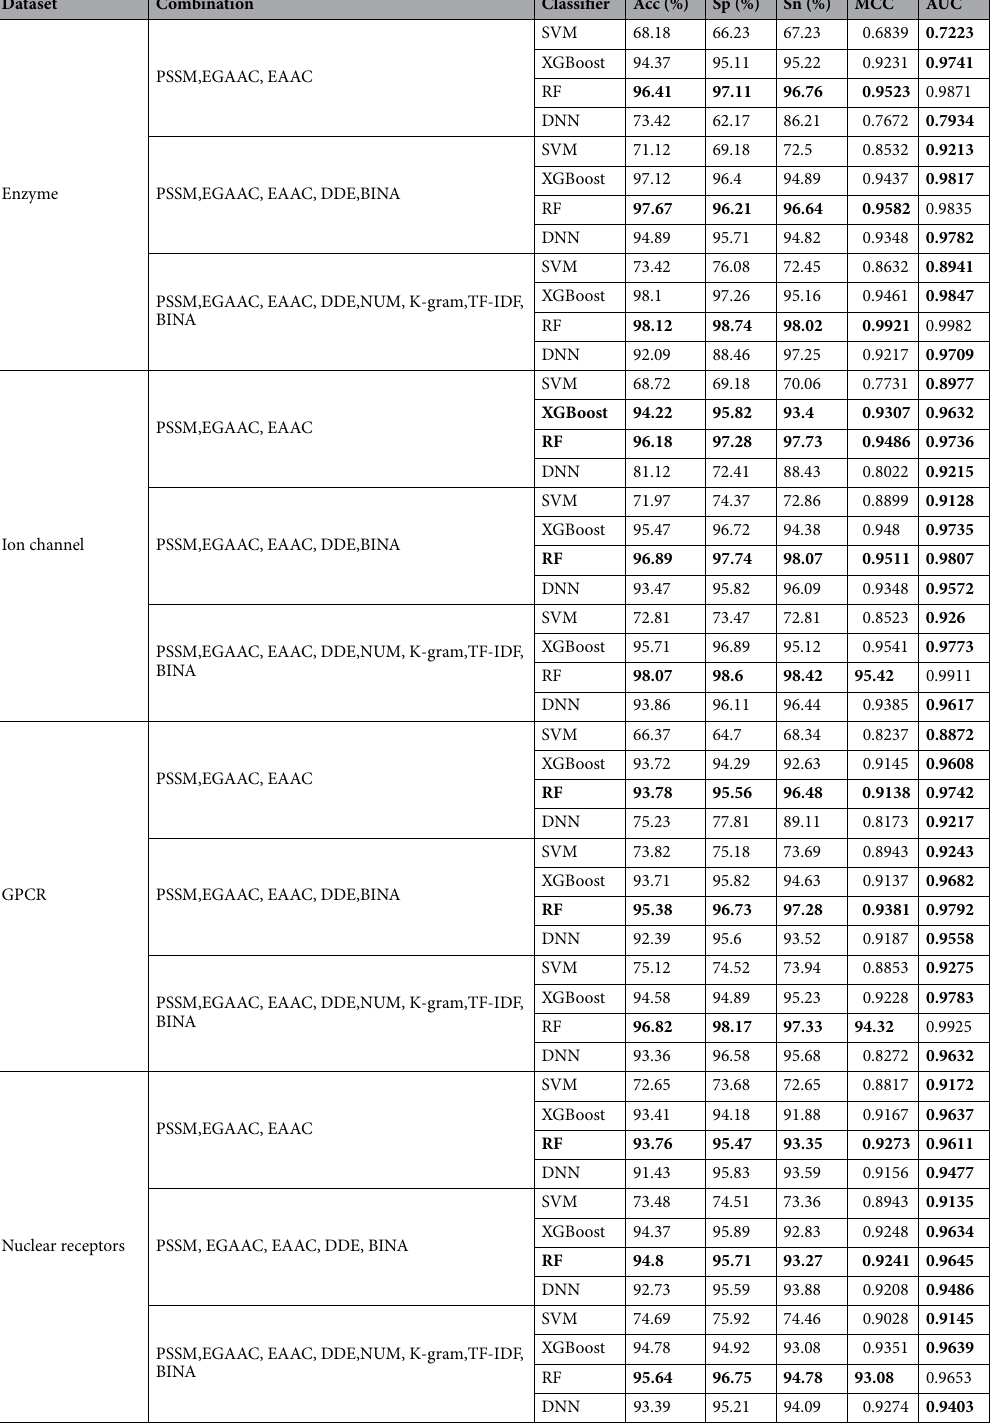
Table 5. Comparison of efficiency criteria of various classifications of different features, with feature selection. Significant values are in